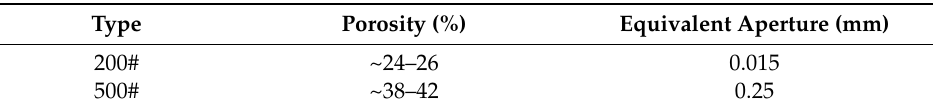
Table 2. Characteristics of porous titanium samples.